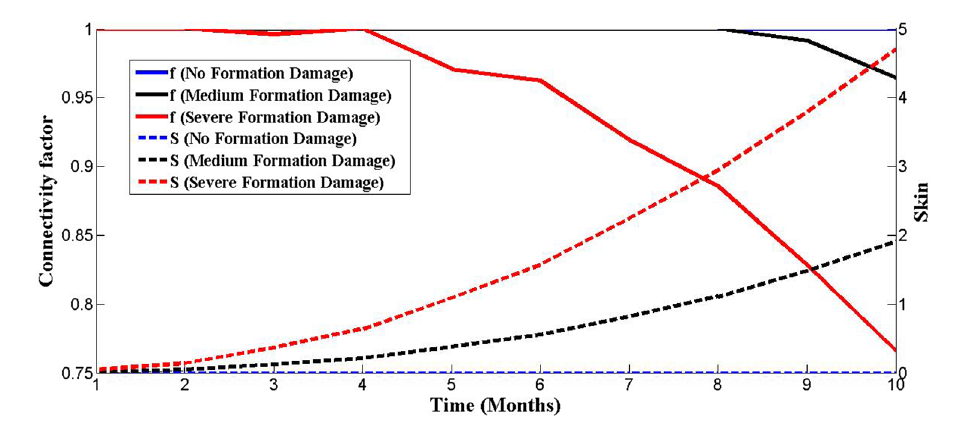
Fig. 6 Connectivity factor ver- sus skin for the synthetic